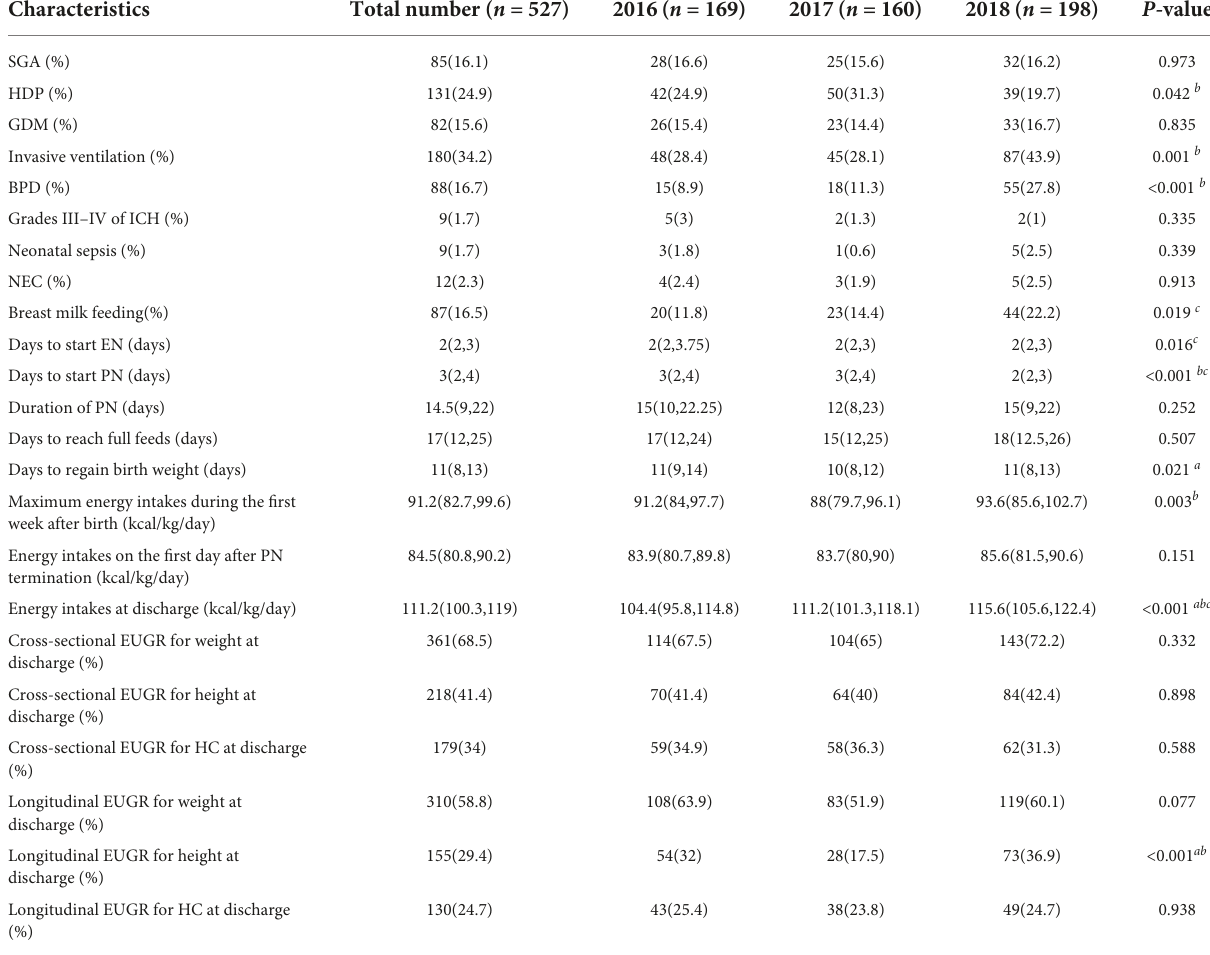
TABLE 2 The neonatal complications and nutritional support of preterm infants during hospitalization.